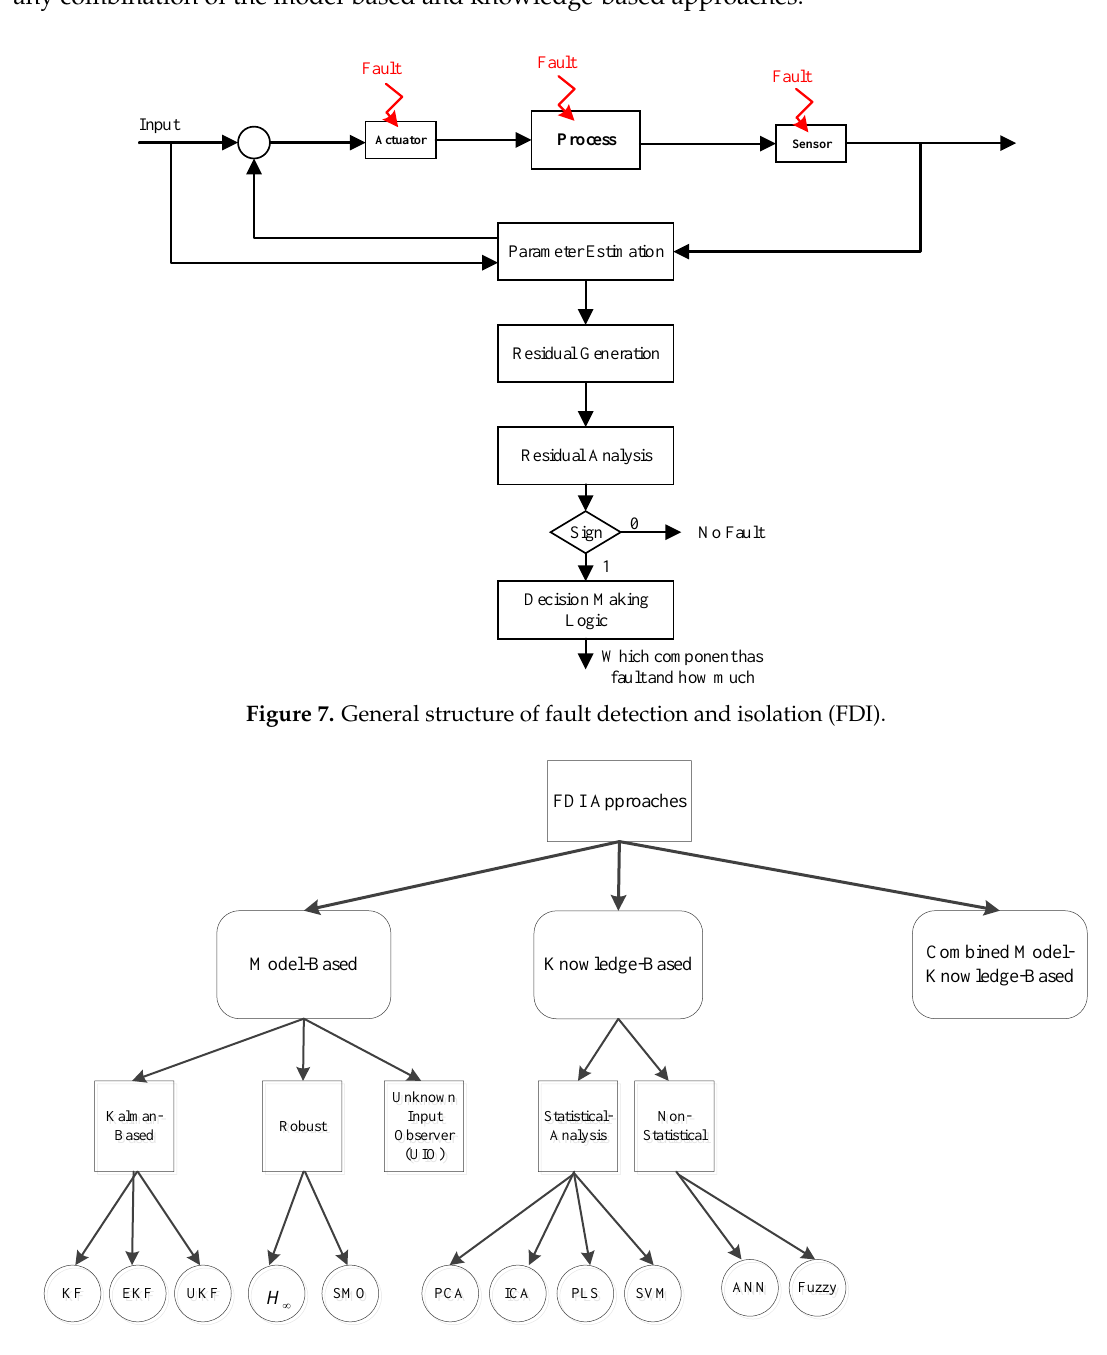
Figure 8. Classification of the FDI approaches based on their methodology. (The abbreviations: KF (Kalman Filter), EKF (Extended Kalman Filter), UKF (Unscented Kalman Filter), SMO (Sliding Mode Observer), PCA (Principal Component Analysis), ICA (Independent Component Analysis), PLS (Partial Least Square), SVM (Support Vector Machine), ANN (Artificial Neural